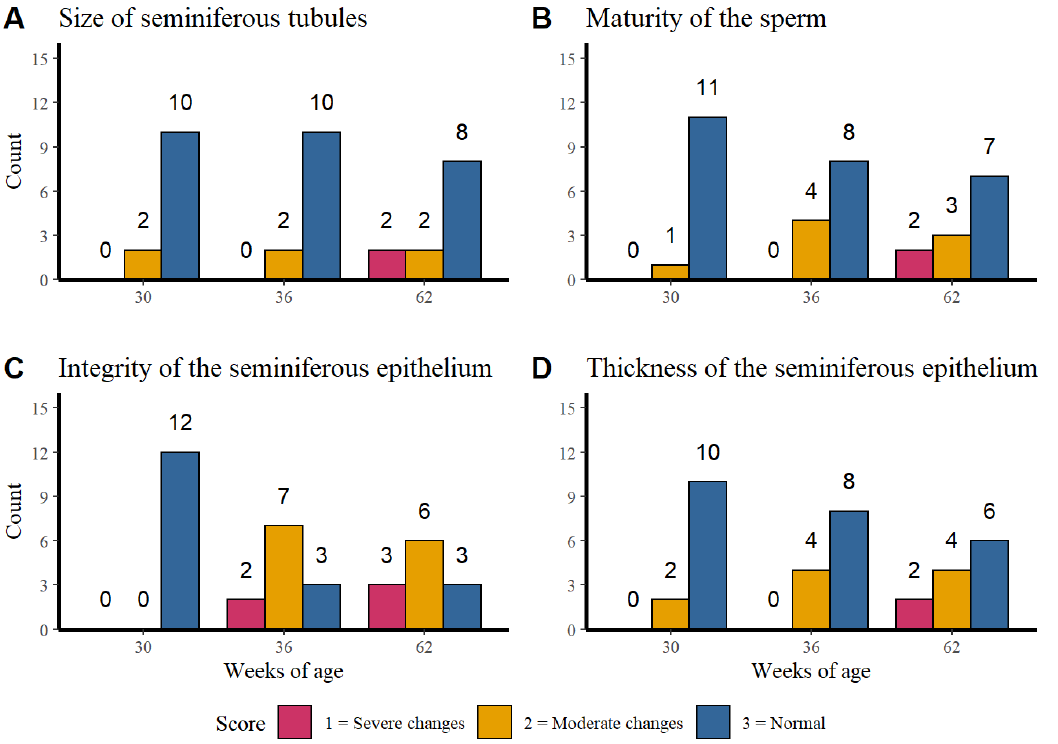
Figure 3. Distribution of the histological finding counts of the seminiferous tubules ( A ), sperm maturation ( B ), integrity of the seminiferous epithelium ( C ), and seminiferous epithelium thickness ( D ) per week of age.